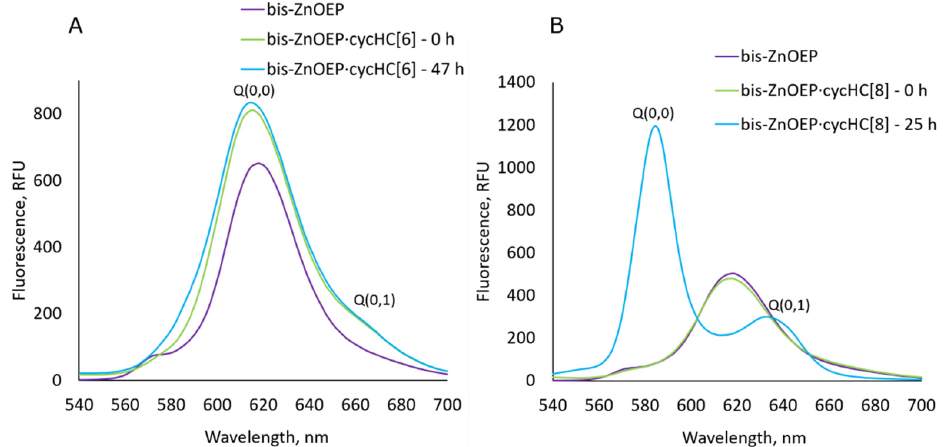
Figure 5. ( A ) Fluorescence spectra ( λ ex = 399 nm ) of free bis–ZnOEP (2.2 × 10 − 6 M, CH 2 Cl 2 , 296 K) and after single addition of 3000 eq of ( R , R )- cycHC[6] in time ( λ ex = 404 nm ) . ( B ) Fluorescence spectra of free bis–ZnOEP (3.0 ∙ 10 − 6 M, CH 2 Cl 2 , 296 K) and after single addition of 2200 eq of ( R , R )- cycHC[8] in time ( λ ex = 413 nm).